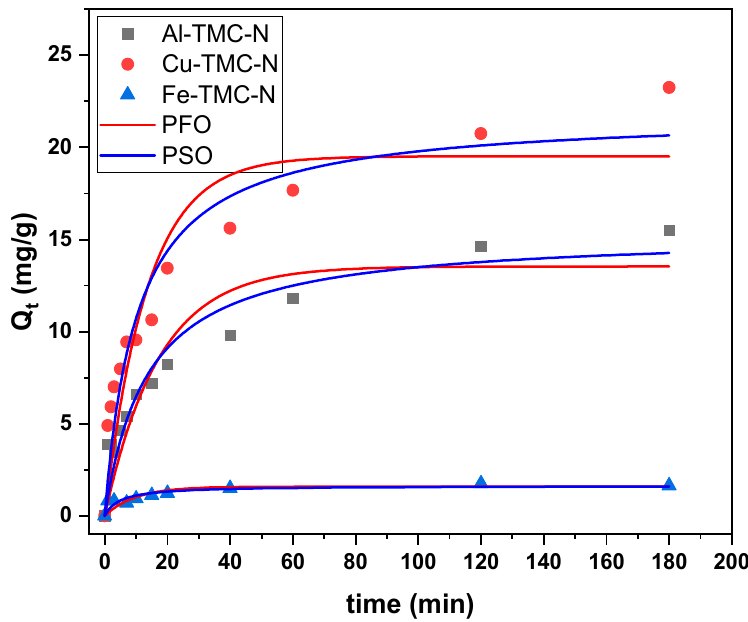
Figure 6. Adsorption kinetic profiles of MO adsorption onto the TMC materials at pH 7 (without buffer): Fe-TMC-N, Cu-TMC-N and Al-TMC-N at 295 K.